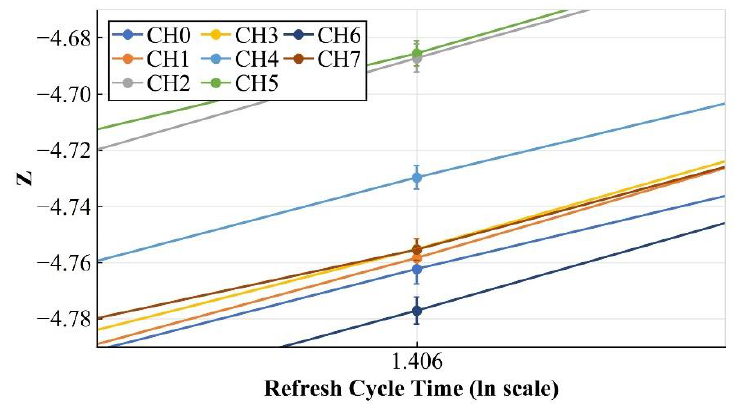
Figure 17. Z-value plot of retention errors with varying RCT under fixed T L of 70 °C in Pseudo channel 0 of all the channels.